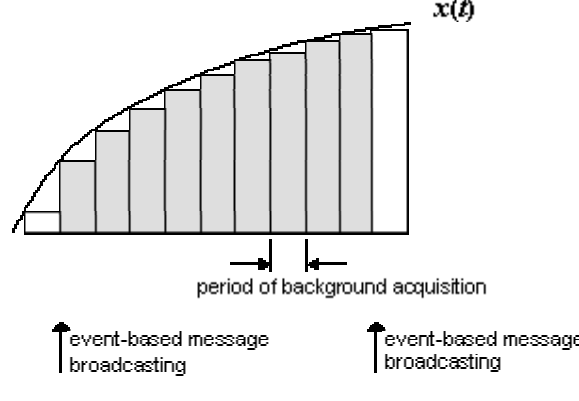
Figure 3. The principle of the integral send-on-delta algorithm based on the "upward" event-driven architecture. The messages are broadcasted when the IAE reaches a prespecified